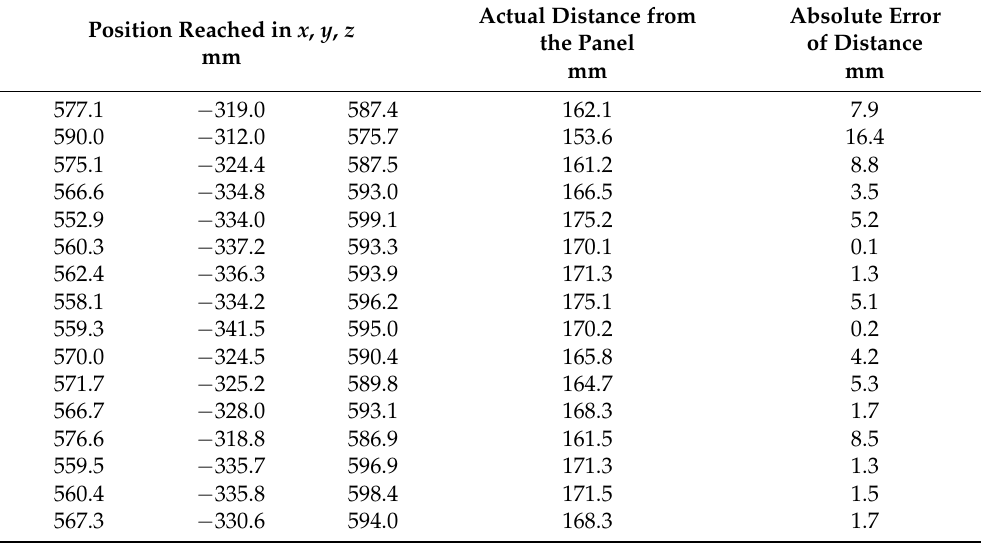
Table 4. Measurement of the distance from panel to the manipulator in the base position obtained by the manipulator for a given distance of 170 mm.